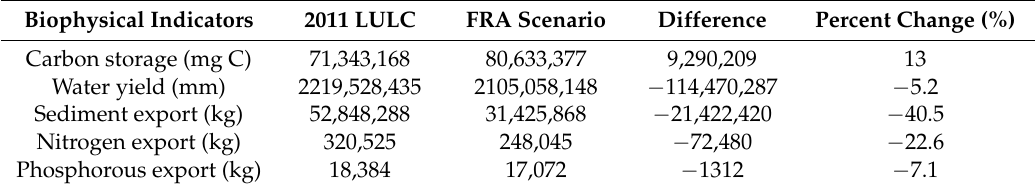
Table 6. The modeled ecosystem service productions under the contemporary 2011 LULC condition and the FRA scenario and their